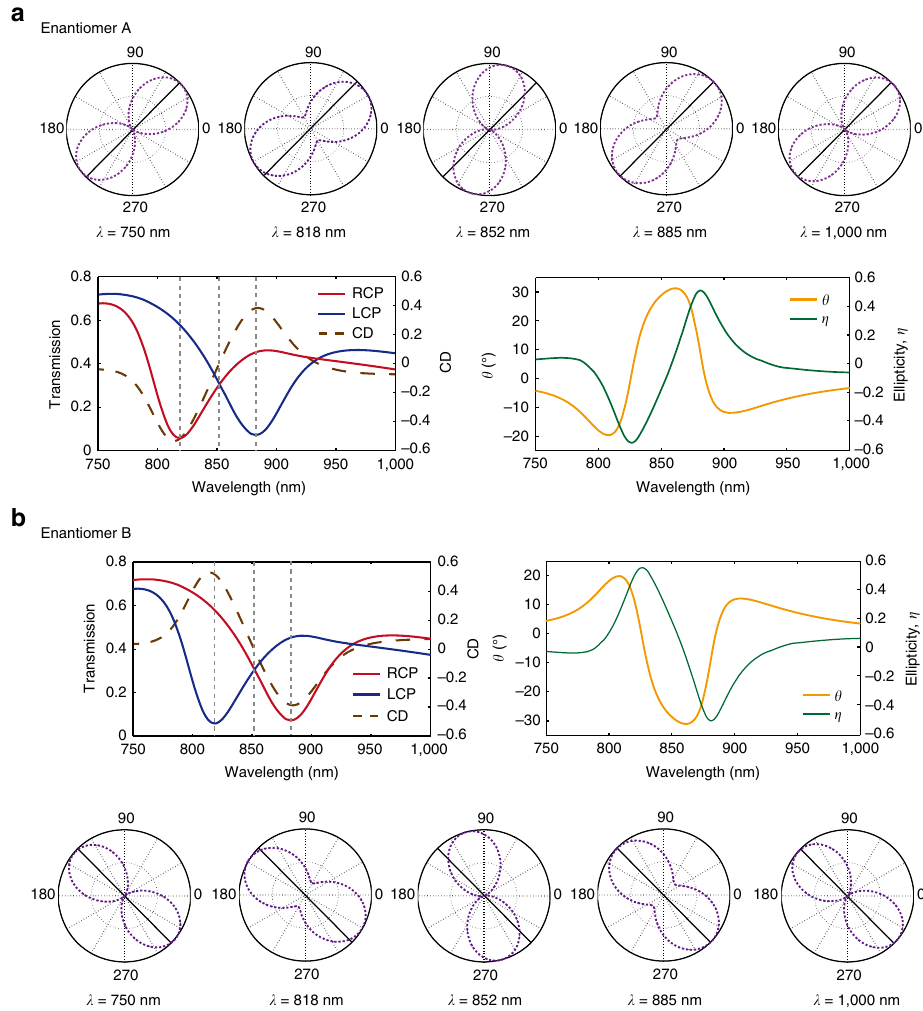
Figure 3 | Simulations of circular dichroism and optical rotatory dispersion. ( a , b ) Simulated transmission spectra of circularly polarized lights on enantiomers A and B. Plots of optical rotation and ellipticity are provided. The input angle of the linearly polarized beam is the same as provided in the experimental data, 45 (cid:2) for enantiomer A and 135 (cid:2) for enantiomer B. A maximum of approximately 30 (cid:2) (clockwise) is obtained for the rotation of a linearly polarized beam as it passes through enantiomer A and approximately (cid:3) 30 (cid:2) (counter clockwise) as it passes through enantiomer B. The angle of rotation indicates the orientation of the major axis of the linear or elliptical beam. The ellipticity describes the shape of the polarization of the electric field, where a value of Z ¼ 0 implies a linearly polarized beam and Z ¼ þ 1 corresponds to a right circular polarization and (cid:3) 1 to a left circular polarization. The responses of the optical rotation and ellipticity data are mirror symmetric for the